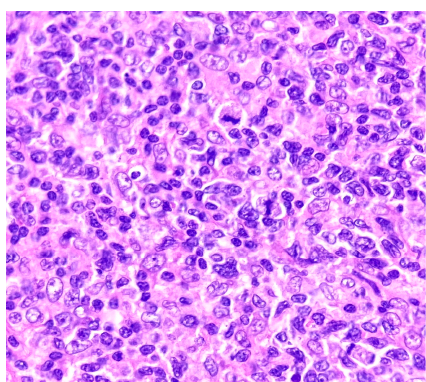
Figure 2. HE staining. Magnification 20×. Figure 3. HE staining. Magnification ×400. Figure 3. HE staining. Magnification ×400. Figure 3. HE staining. Magnification ×